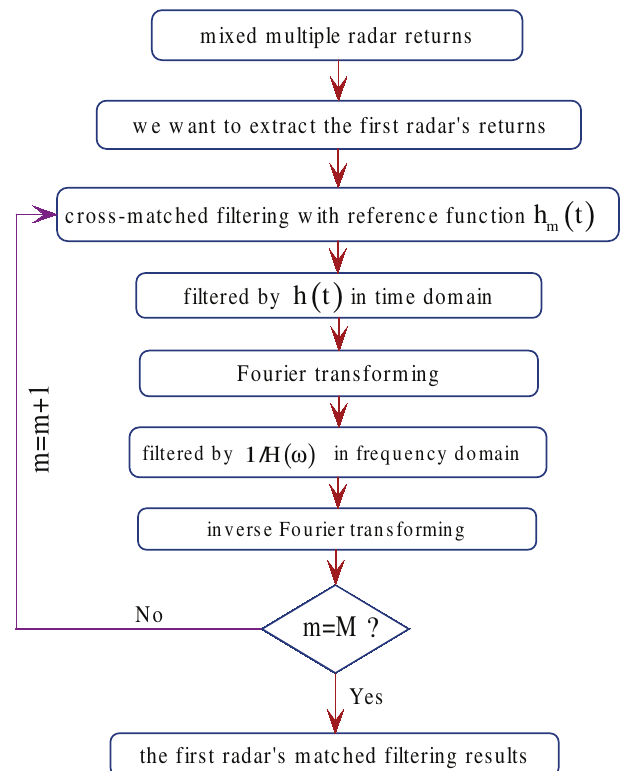
the first radar's matched filtering results